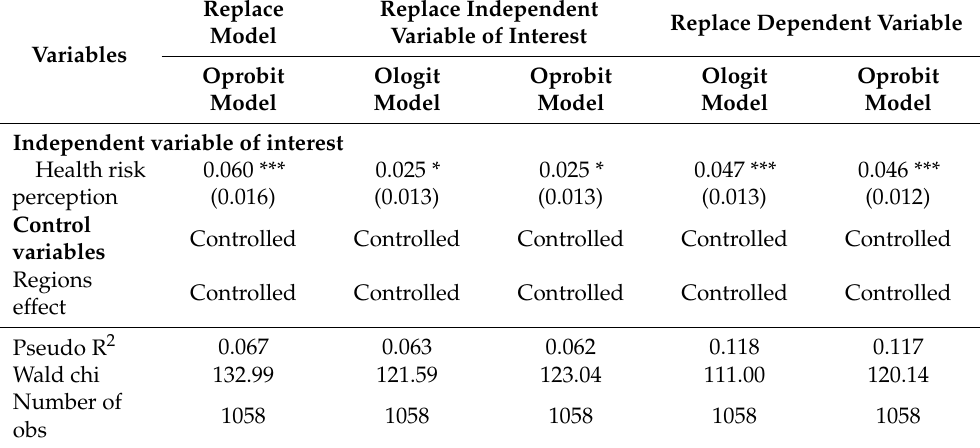
Table 4. Results of robustness